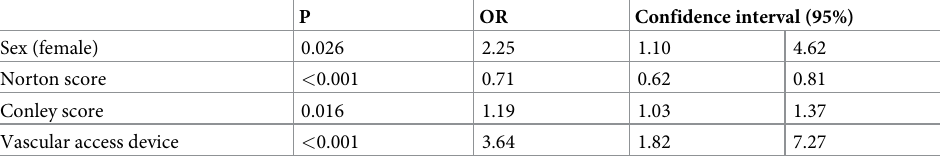
Table 3. Logistic regression model to assess factors associated with mortality during CH stay.